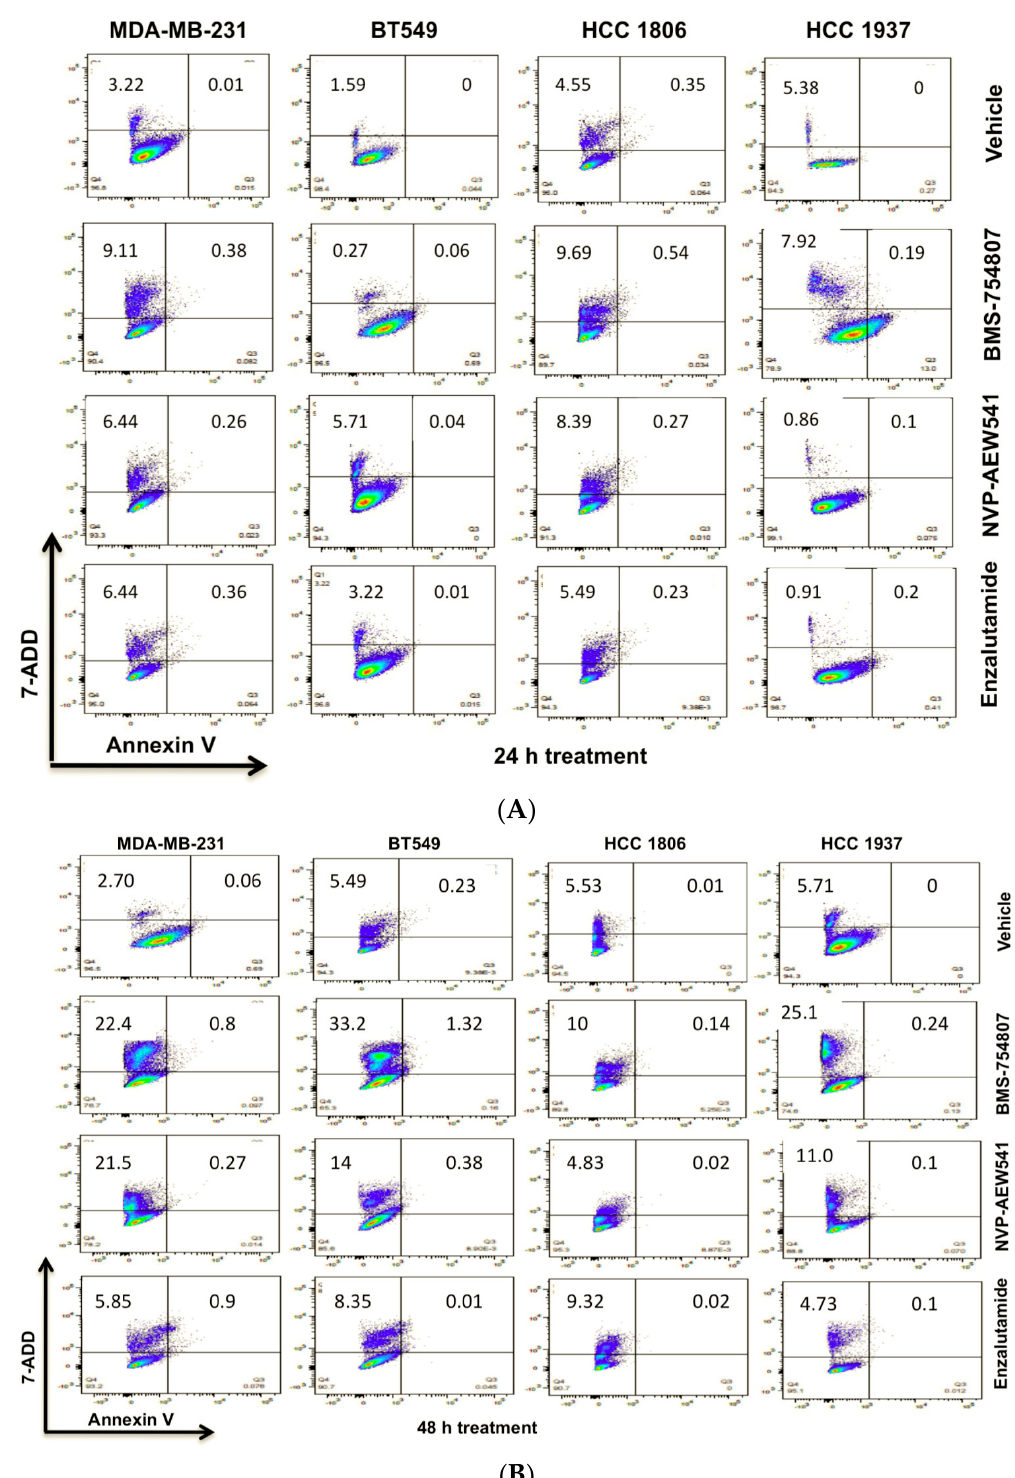
Figure 4. IGF1R/IR antagonists induce TNBC cell death. TNBC cells were grown to 75–80% confluence in complete media, then transferred to the indicated inhibitor-conditioned media for 24 h ( A ) or 48 h ( B ). Cells were harvested and prepared as per the manufacturer’s recommended protocol for flow cytometry using 7-AAD and Annexin-V. Analyses were done using LSRII and FloJo Software.